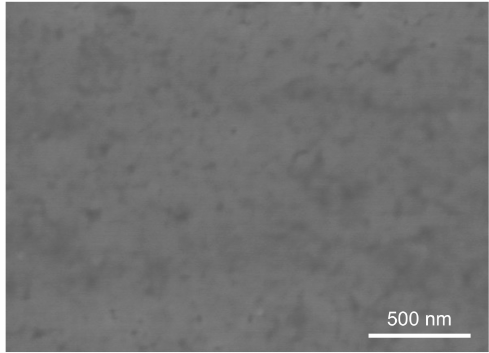
Figure 2. SEM image of the SiO 2 /pHEMA-based composite.